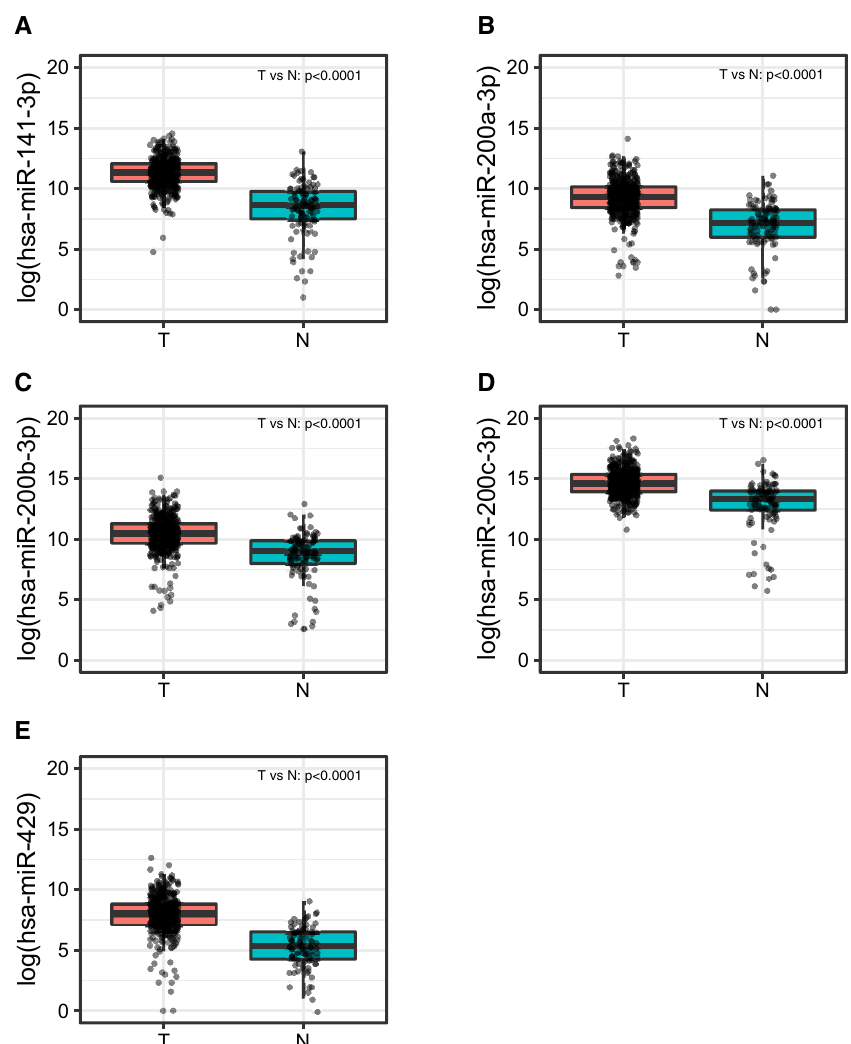
Figure 2. miR-200 family members expression in TCGA-BRCA cohort in tumor tissues (T), and normal breast tissues distant from tumor (N). Plots were performed using the R Foundation for Statistical Computing (version 3.6, packages: ggplot2,